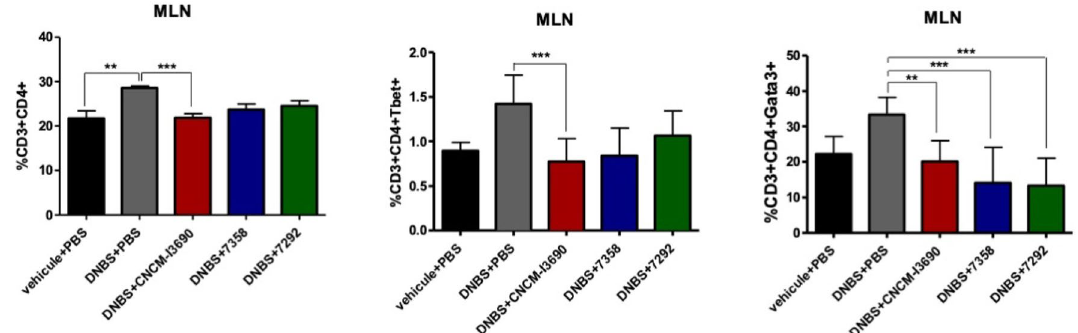
Figure 9. Immunological activity in MLN cells. MLN cells positive for CD3 + , CD4 + , T-bet, or GATA-3 as detected using Flow cytometry. Significance: * p <